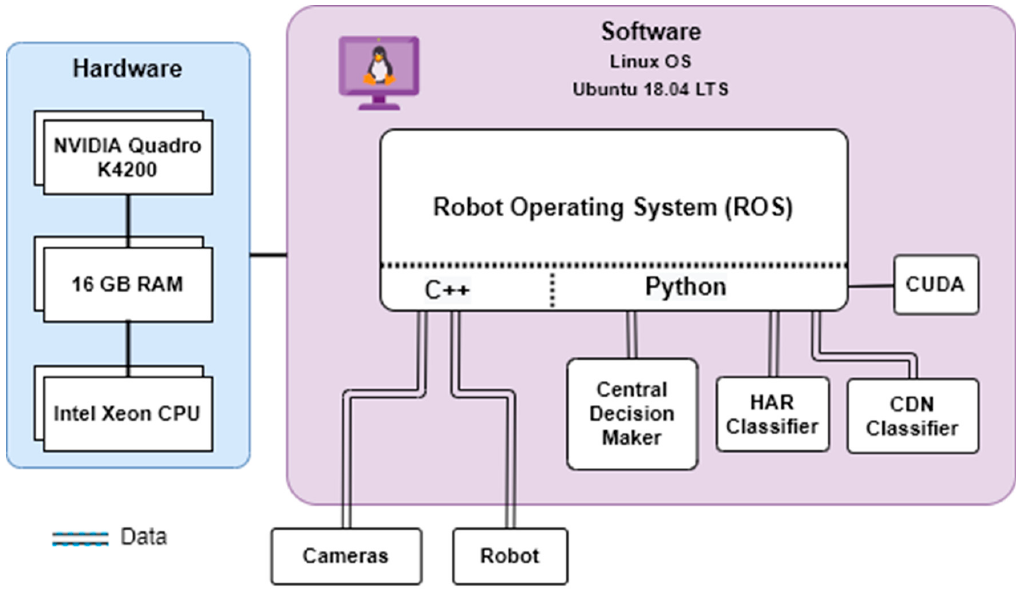
Figure 3. Real-time interface of complex system.